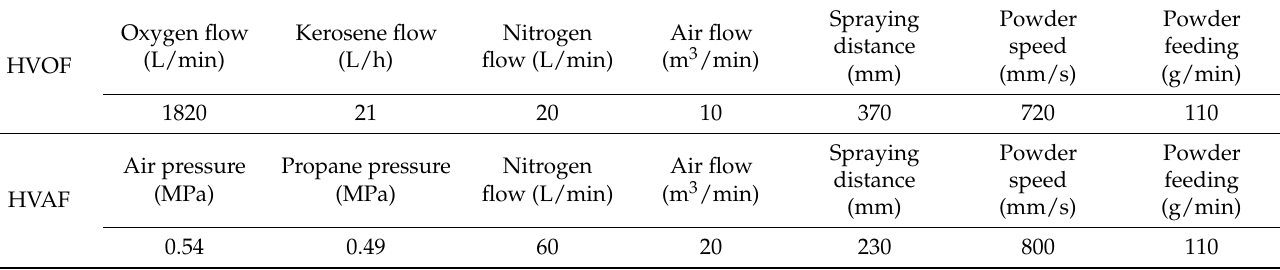
Table 3. Process parameters of HVOF and